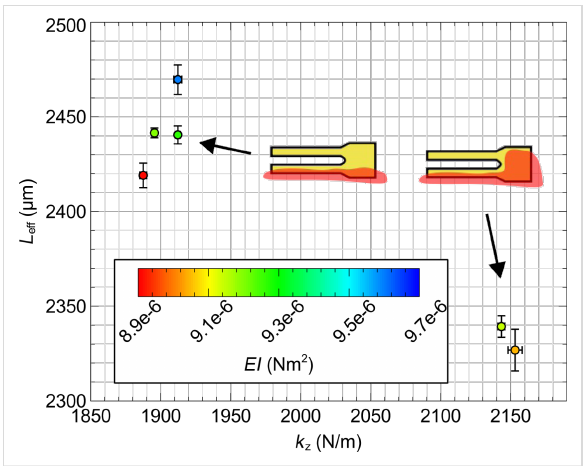
Figure 6: Dependence of the spring constant k z on the effective length of the cantilever L eff . Two distinct values of L eff and corresponding k z are observed depending on the mounting of the tine. The flexural rigidity EI is unaffected by the mounting as expected.